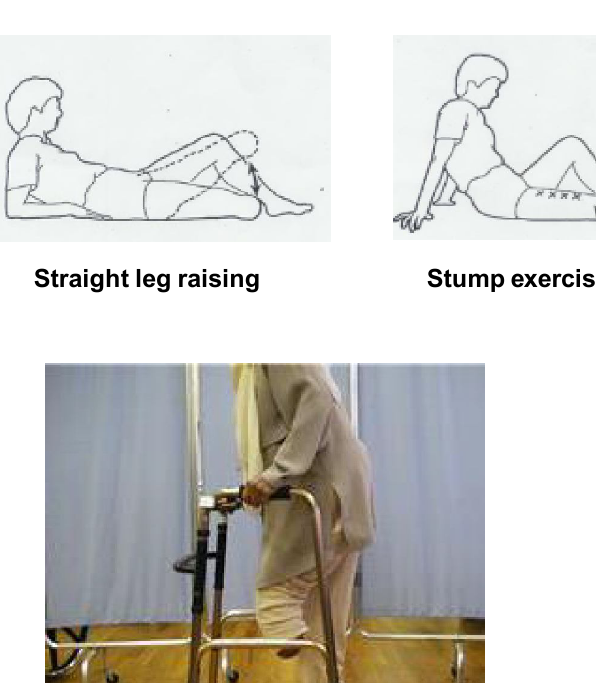
Figure of eight stump bandaging three times a